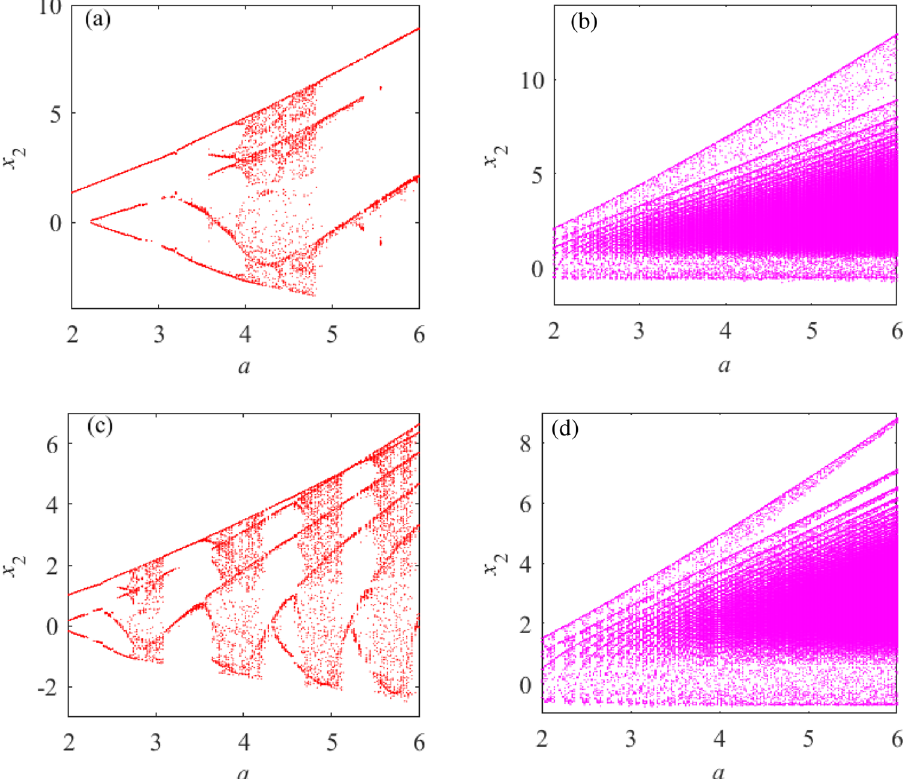
k i k ( 2 ) − 1 and ( 1 ) = ( 1 ) + 1 and the = 2 , the bifurcation diagram of system (8). ( b ) = i i ( 2 ) = 4 , the bifurcation diagram of system (8). ( d ) ( 1 ) = 3 ,